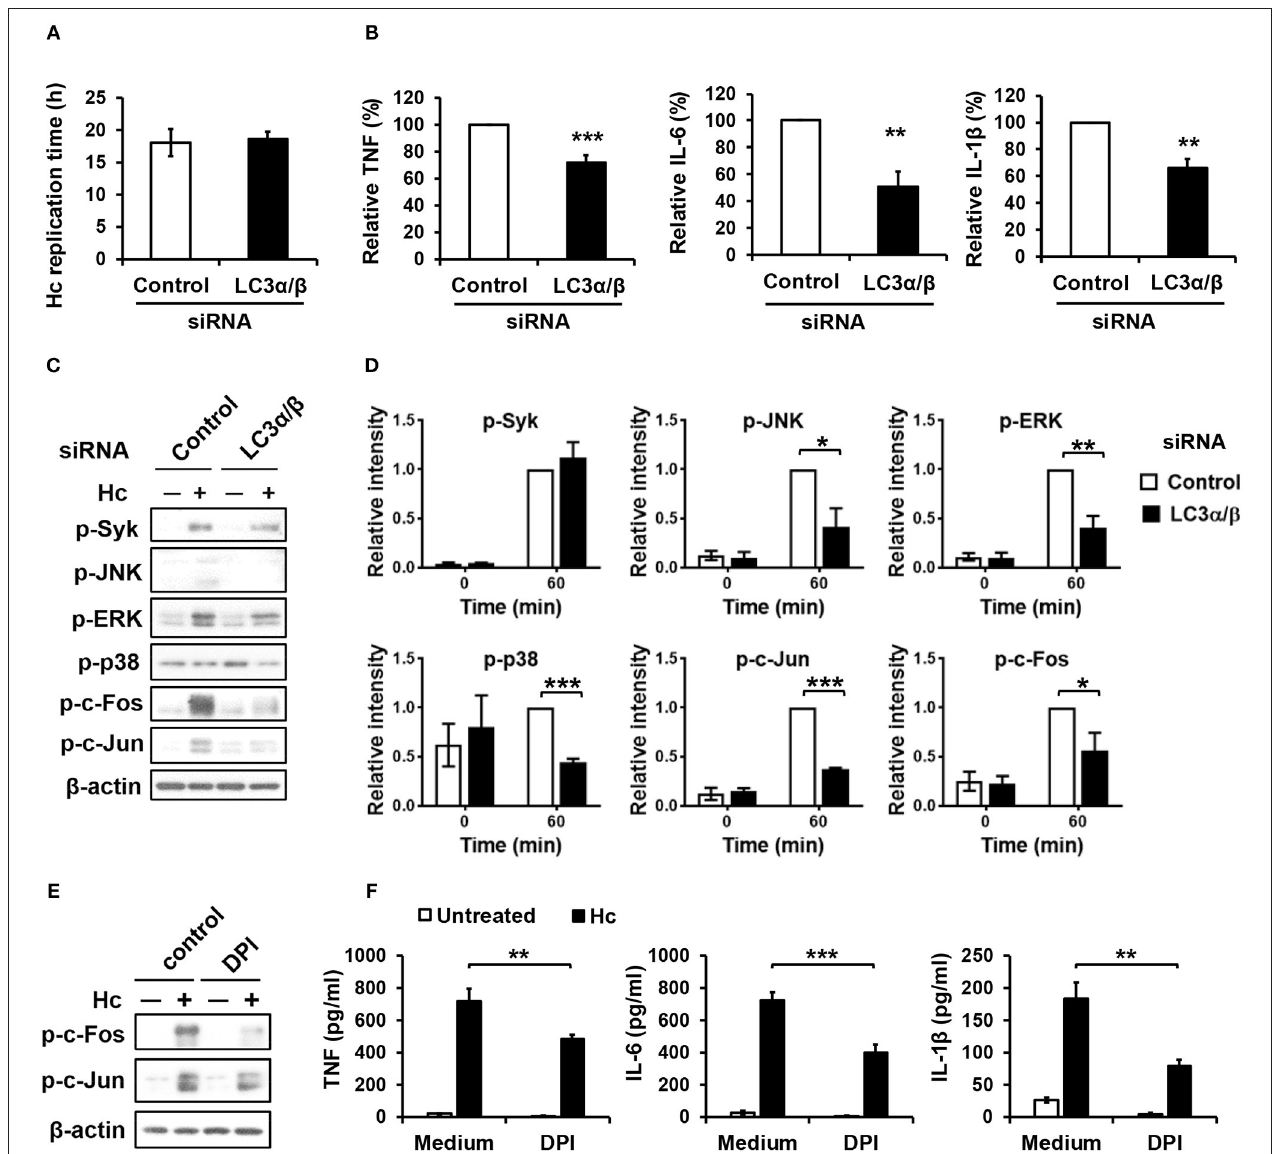
FIGURE 8 | LC3 is required for activation of MAPKs-AP-1 pathway and cytokine production upon H. capsulatum stimulation. (A–D) Macrophages from WT mice were transfected with control siRNA or siRNA against LC3 α / β (25nM) for 72h before stimulation with H. capsulatum [MOI = 2 (A) and 5 (B,C) ]. For (A) , macrophages were washed to rid of unengulfed yeasts at 1h after stimulation then lysed immediately (0h) or after 18h of incubation, and the number of yeast cells were counted. Replication time (h) = incubation interval/number of divisions ( n = 5). For (B) , culture supernatants were collected at 18h after stimulation, and the concentrations of TNF, IL-6, and IL- β in the supernatants were quantified by ELISA and are presented as the relative levels of each cytokine ( n = 6 for TNF and IL-6; n = 4 for IL-1 β ). For (C) , cell lysates were collected at 1h after stimulation and analyzed by Western blotting for the expression of indicated proteins. Relative intensity of indicated protein normalized against the corresponding β -actin was shown in (D) ( n = 3). (E,F) Macrophages from WT mice were treated with or without DPI (5 µ M) for 1h prior to stimulation with H. capsulatum (MOI = 5). Cell lysates were collected at 1h after stimulation and analyzed by Western blotting (E) . Culture supernatants were collected at 18h after stimulation, and the concentrations of TNF, IL-6, and IL- β in the supernatants were quantified by ELISA ( n = 4) (F) . Bars represent the mean ± SEM, * p ≤ 0.05, ** p ≤ 0.01, *** p ≤ 0.001 [2-tailed t -test (A,B, D) ; ANOVA with Bonferroni’s multiple comparisons post-hoc test (F)